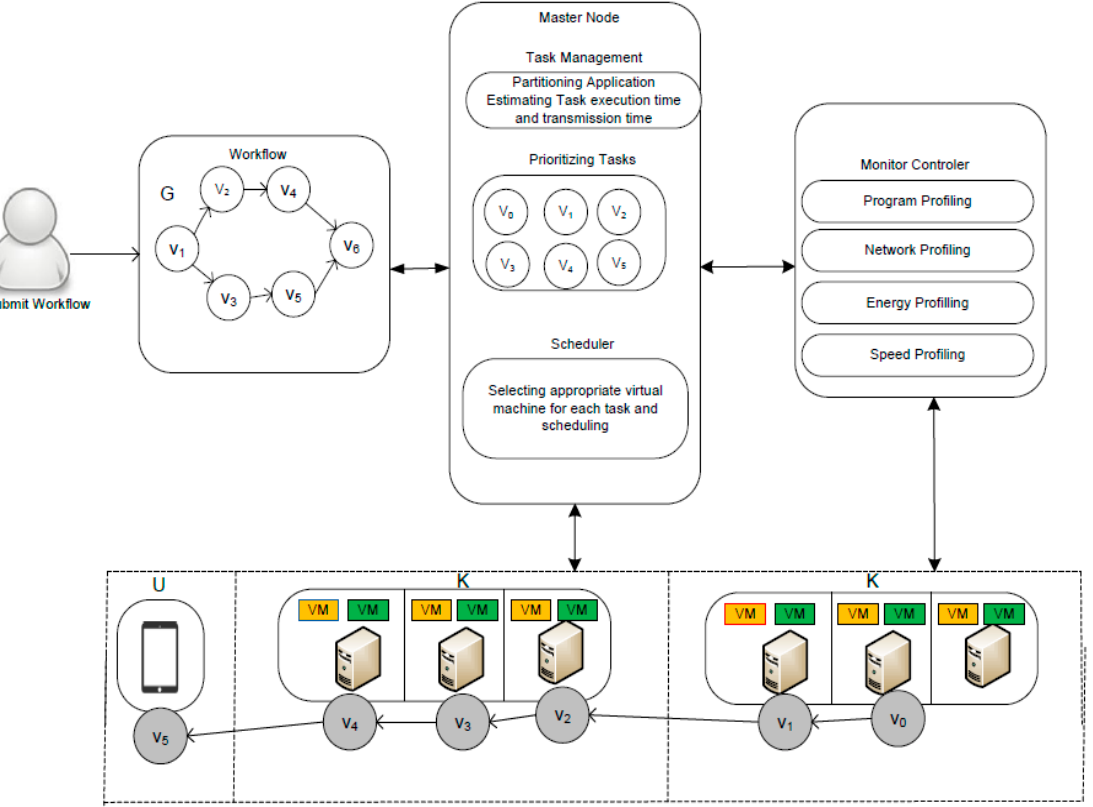
Figure 2. Mobile cloud architecture.